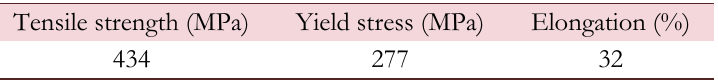
Table 3: Mechanical properties of